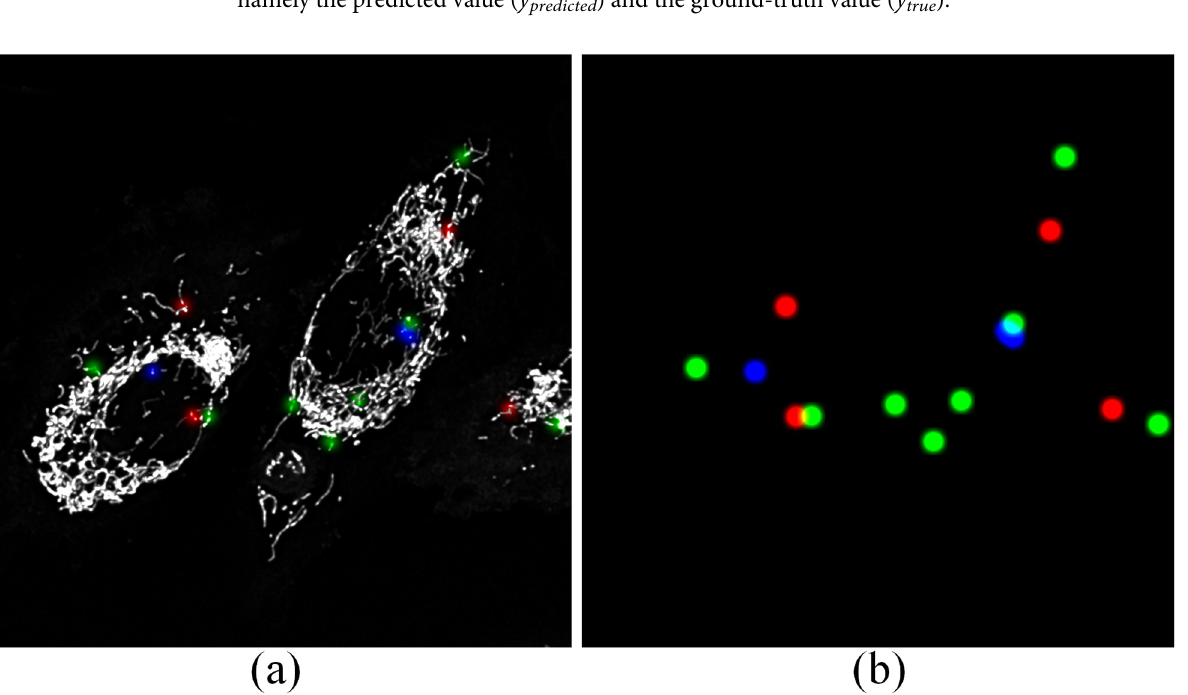
Fig 1. Maximum intensity projections of the two output z-stacks, which are generated by MEL. (A) The first z-stack contains the localised mitochondrial events that were superimposed on the mitochondrial structures, and (B) the second z-stack contains only the localised events. The contrast and saturation of the z-stacks where enhanced for visual